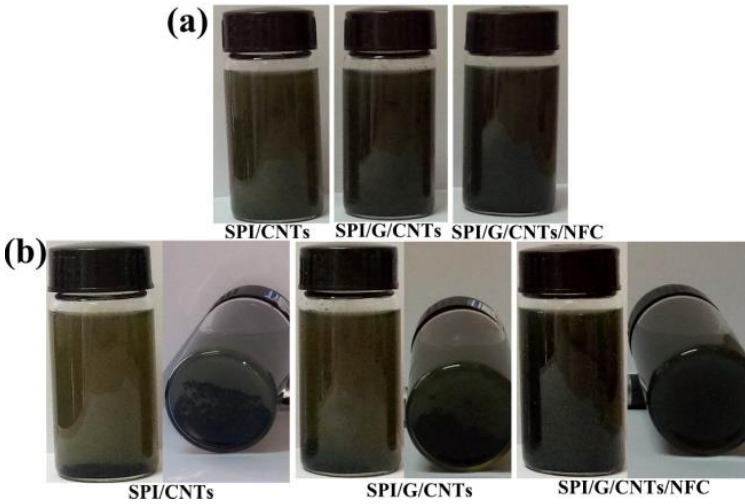
Figure 4. The dispersion of SPI/CNT, SPI/G/CNT, and SPI/G/CNT/NFC solutions after standing for ( a ) 1 min and ( b ) 2 h.